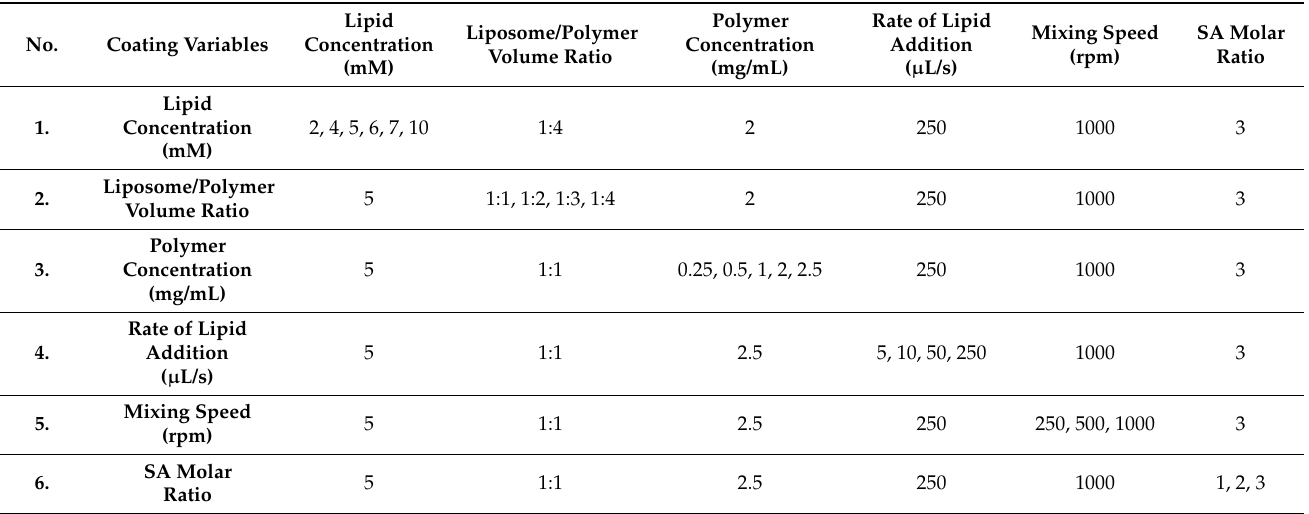
Table 3. Tested parameters that potentially affect the coating process. To isolate the effect of each coating variable under test (from row 1 to 6), the other parameters in each row were